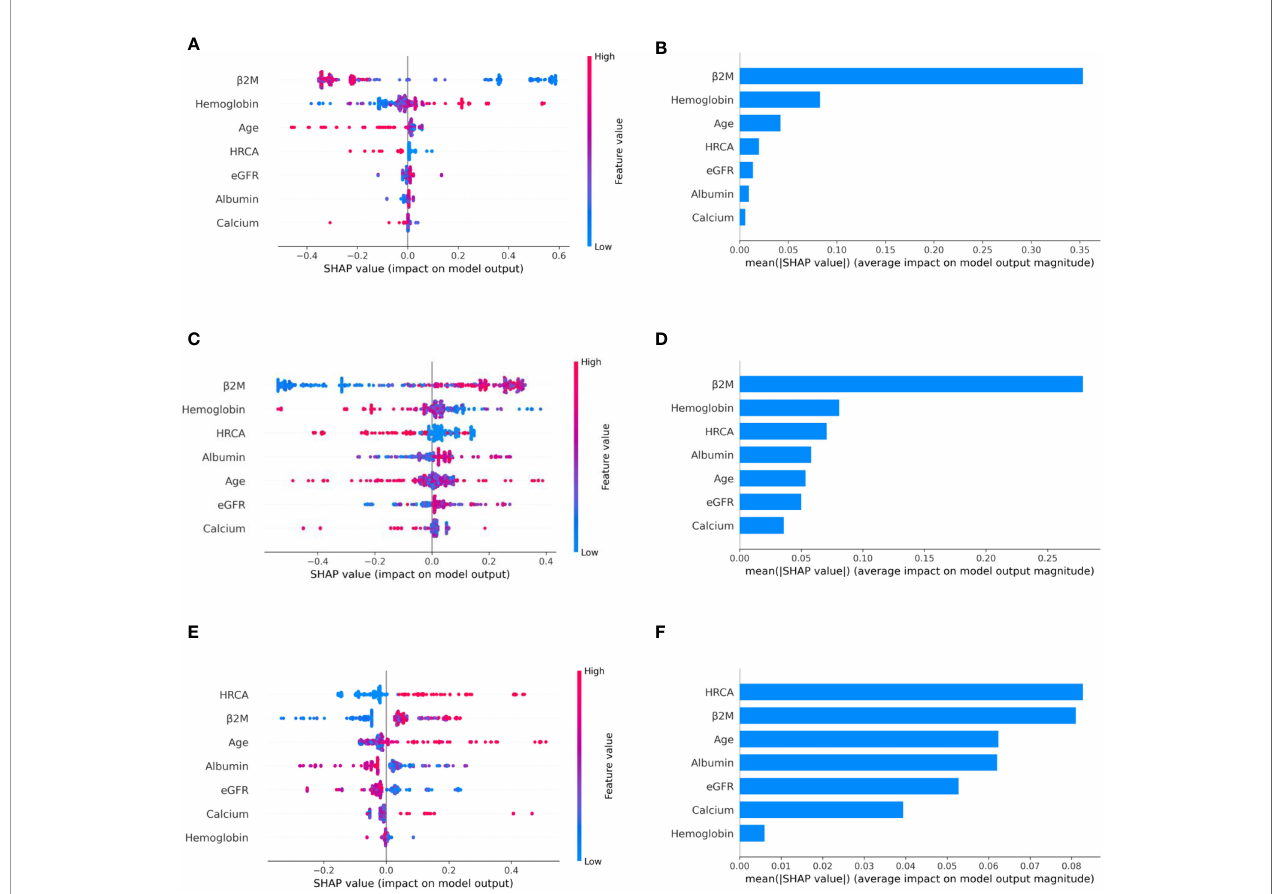
FIGURE 3 | Model interpretation using SHAP (SHapley Additive exPlanations). SHAP summary plots for different risk stages inferred from MMIn data showing the relative impact of different parameters (top to bottom) contributing to a particular risk stage prediction. (A, B) CRSS-1: Normal levels of b 2M and hemoglobin are the key contributors to the low-risk stage prediction. Furthermore, high values of age on the left side of the summary plot are pushing the model away from the low-risk prediction and are indicative of either intermediate or high risk. Overall, b 2M has the highest impact and calcium has the lowest impact on the low-risk stage prediction. (C, D) CRSS-2: b 2M and hemoglobin are the key contributors to the intermediate-risk stage. Elevated levels of b 2M with lower levels of hemoglobin are indicative of intermediate risk. (E, F) CRSS-3: Presence of HRCA is contributing the most to the high-risk stage. Elevated values of b 2M and calcium and lower levels of albumin, hemoglobin, and eGFR are contributing toward the high-risk stage